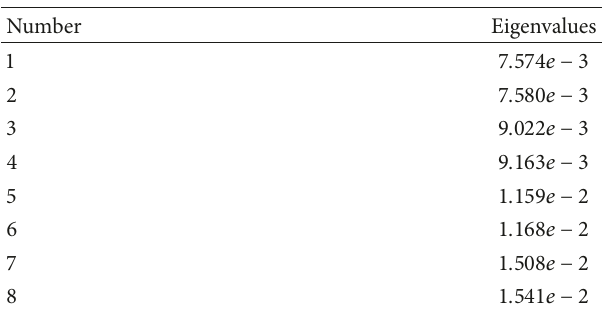
Table 5: Eigenvalues near 0.01.